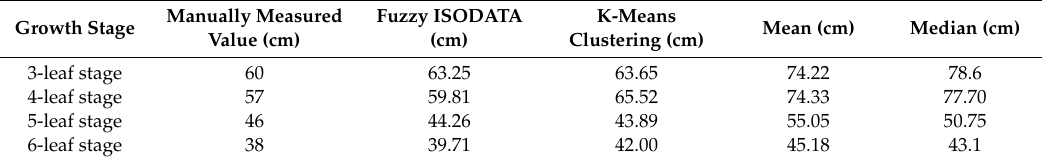
Table 2. Calculated and manually measured values of distance from the sensor to the canopy with different algorithms. ISODATA: Iterative Self-Organizing Data Analysis Technique Algorithm. Growth